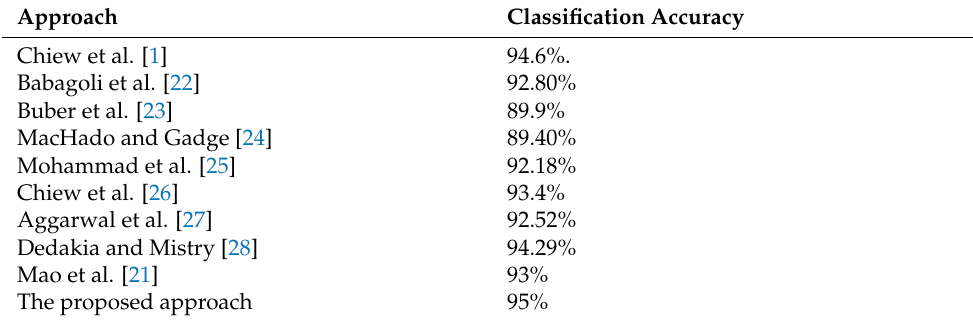
Table 5. Comparison between the proposed approach and prior